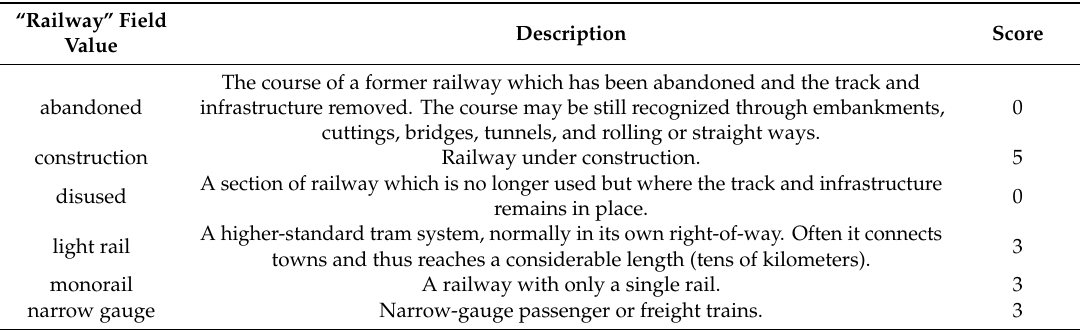
Table 5. Pressure scores assigned to di ff erent types of railways from the OSM